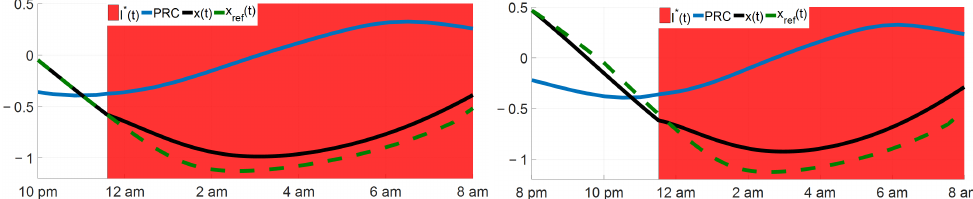
Figure 9. Comparison of the circadian state x ( t ) (black solid line) under the optimal light I ∗ ( t ) (red region) and the reference state x ref ( t ) (green dash line) in the night-shift from 10 pm to 8 am ( left ) and night-shift from 8 pm to 8 am ( right ). The blue line in each subfigure shows the PRC value of the CBT